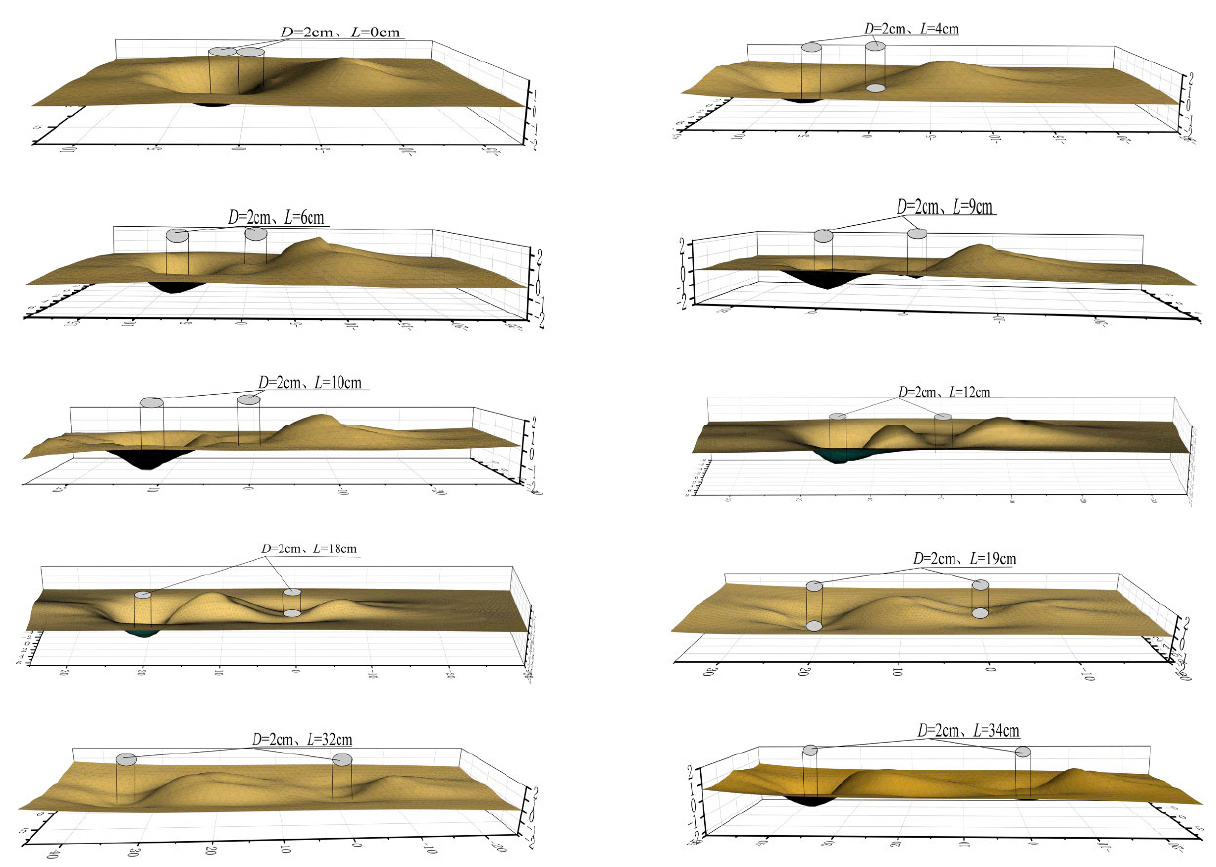
Figure 4. Three-dimensional local scour patterns around tandem double piers for different pier Figure 4. Three ‐ dimensional local scour patterns around tandem double piers for different pier spacing ratio L / D (Note: H = 20 cm, D = 2 cm, and V = 0.2 m/s). spacing ratio L / D (Note: H = 20 cm, D = 2 cm, and V = 0.2